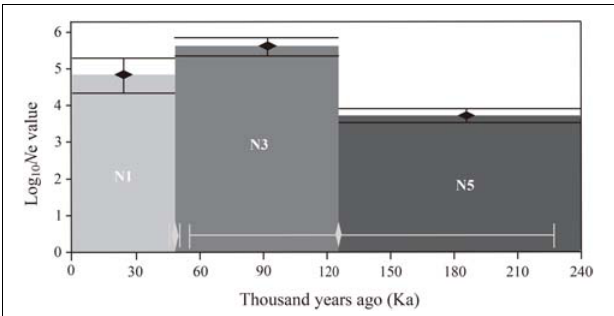
FIGURE 10 | Schematic representation for the estimates of effective population size and the effective population size transition time of the best DIYABC scenario (Scenario 7). Black vertical bars and white horizontal bars represent 95% confidence intervals for the estimates of effective population size and effective population size transition time, respectively. Note that the y -axis of effective population size value is in log 10